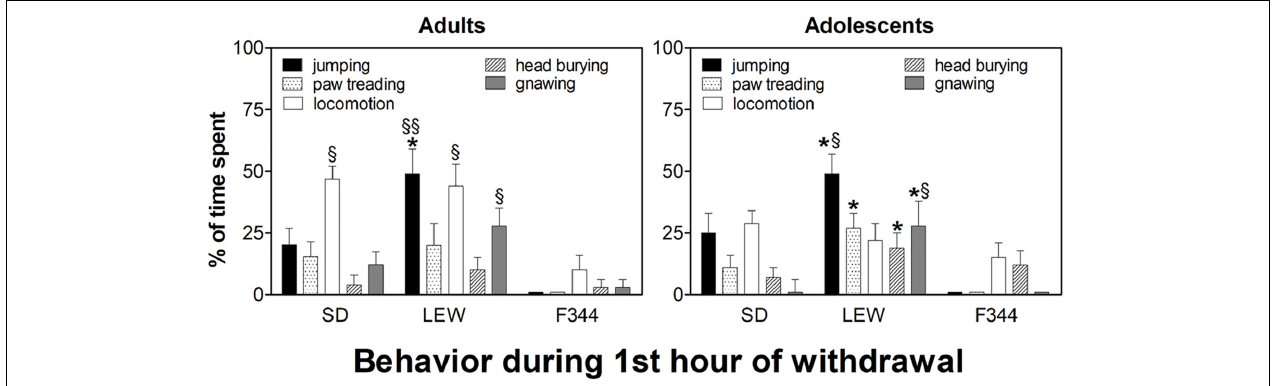
FIGURE 8 | Behavioral reactions during the first hour of withdrawal in the three strains in adult and adolescent onset rats. Data are expressed as means ± SEM. Results from the day after the 8th and 19th drinking sessions were pooled since no significant difference was observed. * p < 0.05 Lewis (LEW) vs. Sprague-Dawley (SD), § p < 0.05 LEW and SD vs. Fischer 344 (F344), §§ p < 0.001 LEW vs. F344 by one-way ANOVA followed by Tukey’s post hoc